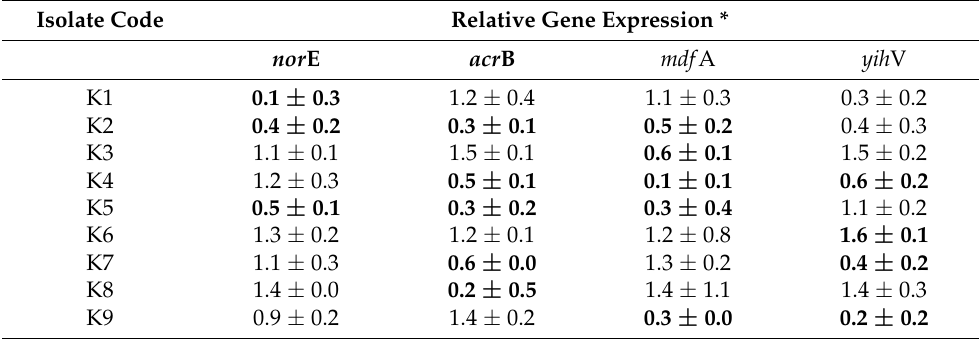
Table 2. Relative gene expression (mean ± SD) for the tested K. pneumoniae isolates after treatment with C. thouarsii extract (2–16 µ